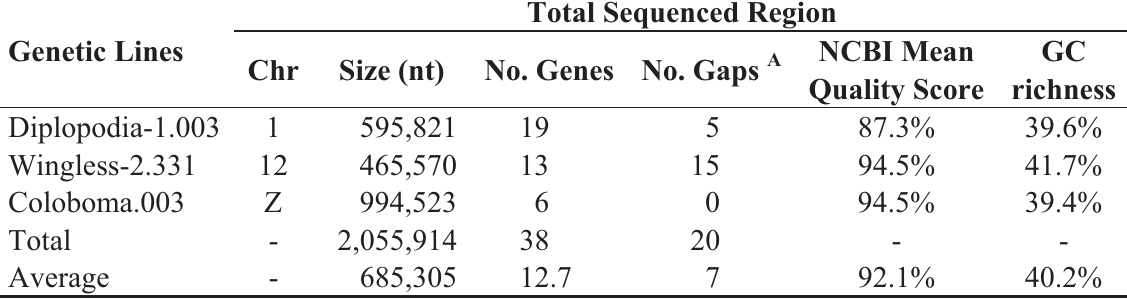
Table 1. Statistics of the three regions captured using the targeted genomic capture enrichment